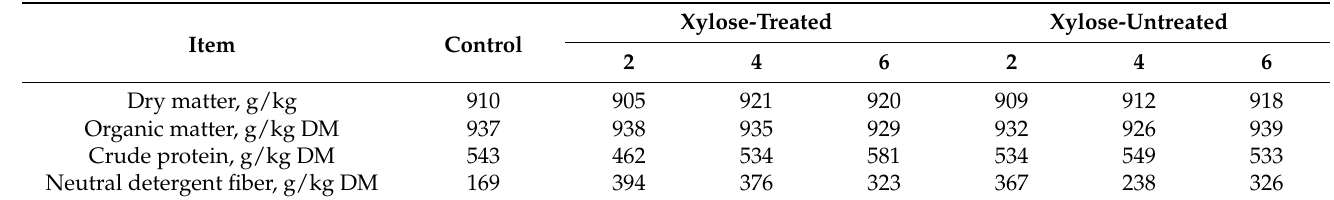
Table 3. Chemical composition of experimental ingredients of Experiment 3—microwave